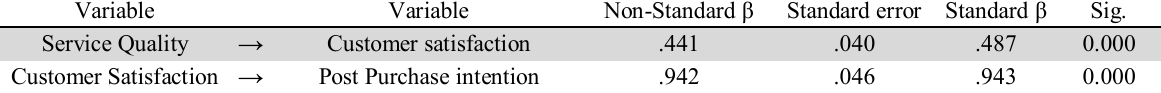
The summary of directs effects